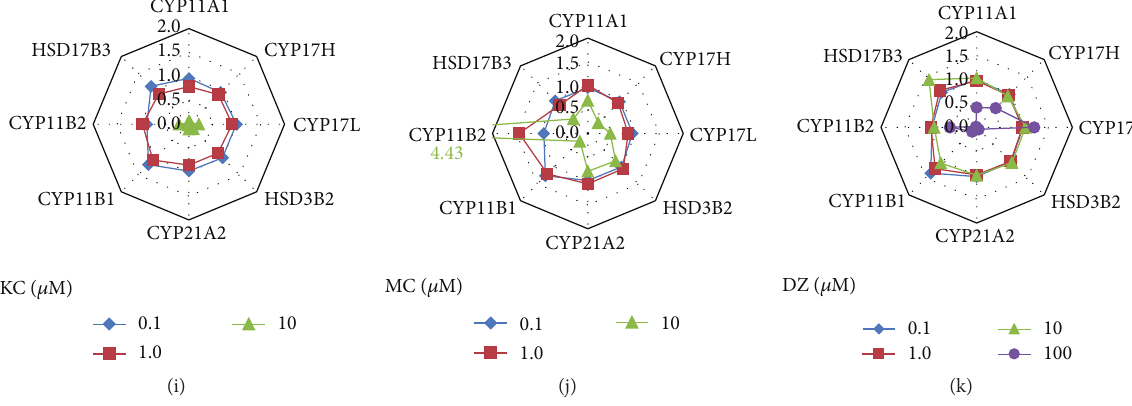
Figure 5: Estimated mechanism of action of adrenal toxicants by using the mathematical model of adrenal steroidogenesis in NCI-H295R cells. Mechanisms of action of adrenal toxicity compounds were quantitatively estimated from experimental results of differential steroid profiling using the mathematical model of adrenal steroidogenesis in NCI-H295R cells. The drug action was defined as a scaling factor of enzymatic activity in the simulation model. These scaling factors were optimized to fit experimental data by a hybrid optimization method of the RCGA and nonlinear least squares. Estimated drug actions by the exposure of vasculotoxic agents acrylonitrile: AN (a), fumaronitrile: FN (b), salinomycin: SM (c), and thioguanine: TG (d) and the steroidogenic inhibitors aminoglutethimide: AGT (e), o,p 󸀠 - DDD: DDD (f), spironolactone: SP (g), metyrapone: MP (h), ketoconazole: KC (i), miconazole: MC (j), and daidzein: DZ (k) are shown as a spider radar chart. CYP11A1: P450 side chain cleavage enzyme, CYP17H: 17 𝛼 -hydroxylase of CYP17, CYP17L: C 17 HSD3B2: 3 𝛽 -hydroxysteroid dehydrogenase, CYP21A2: 21-hydroxylase, CYP11B1: 11 𝛽 -hydroxylase, CYP11B2: 18-hydroxylase, and HSD17B3: 17 𝛽 -hydroxysteroid